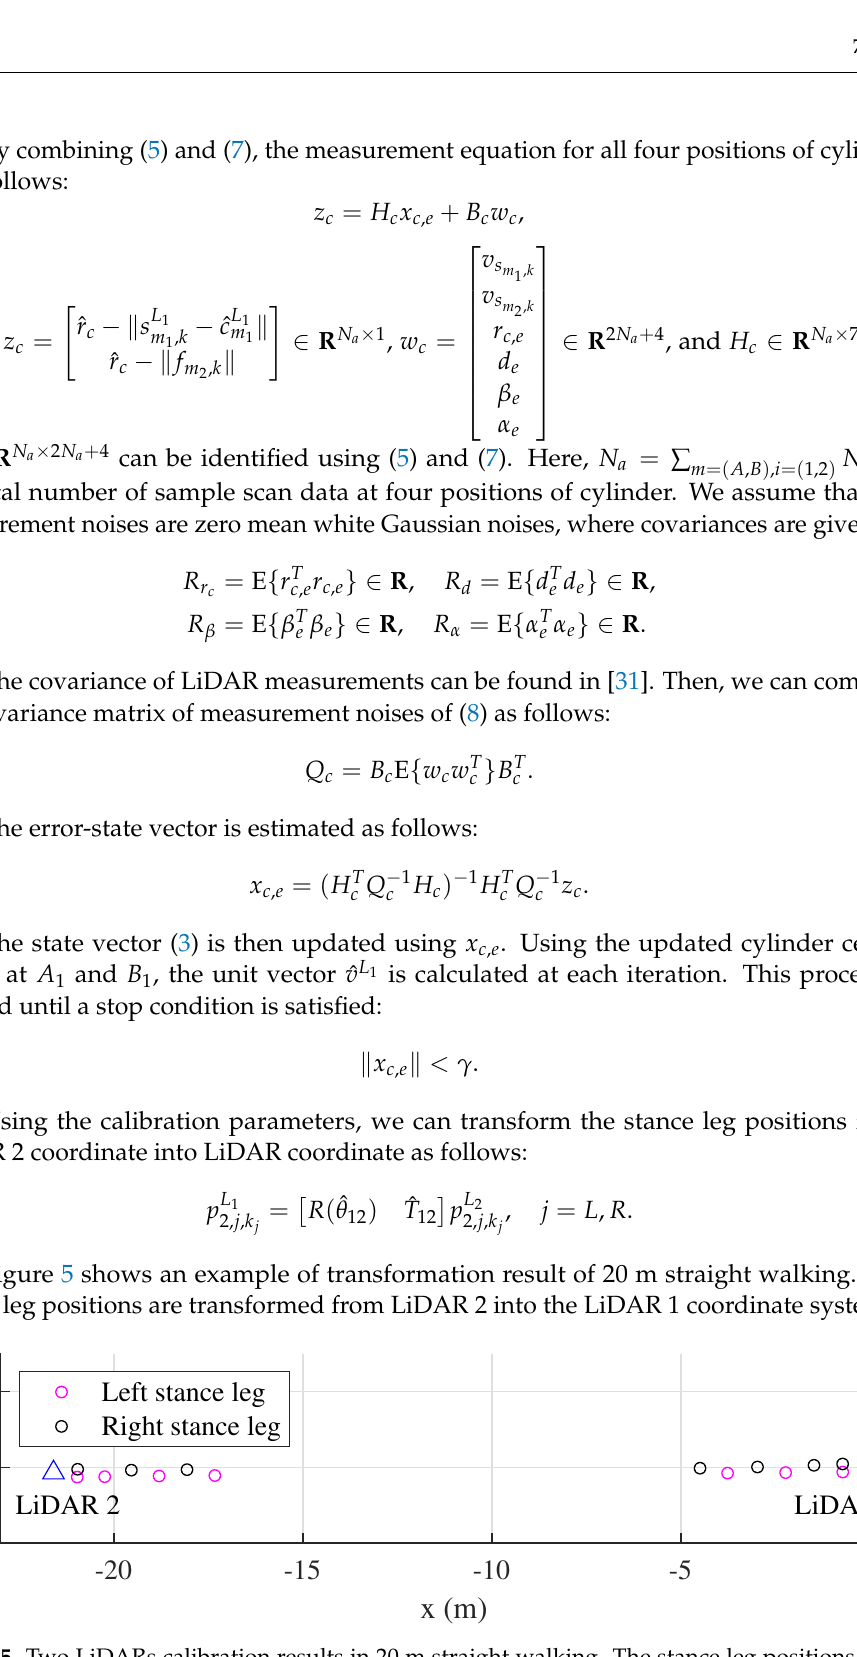
Figure 5. Two LiDARs calibration results in 20 m straight walking. The stance leg positions from LiDAR 2 are transformed into the LiDAR 1 coordinate